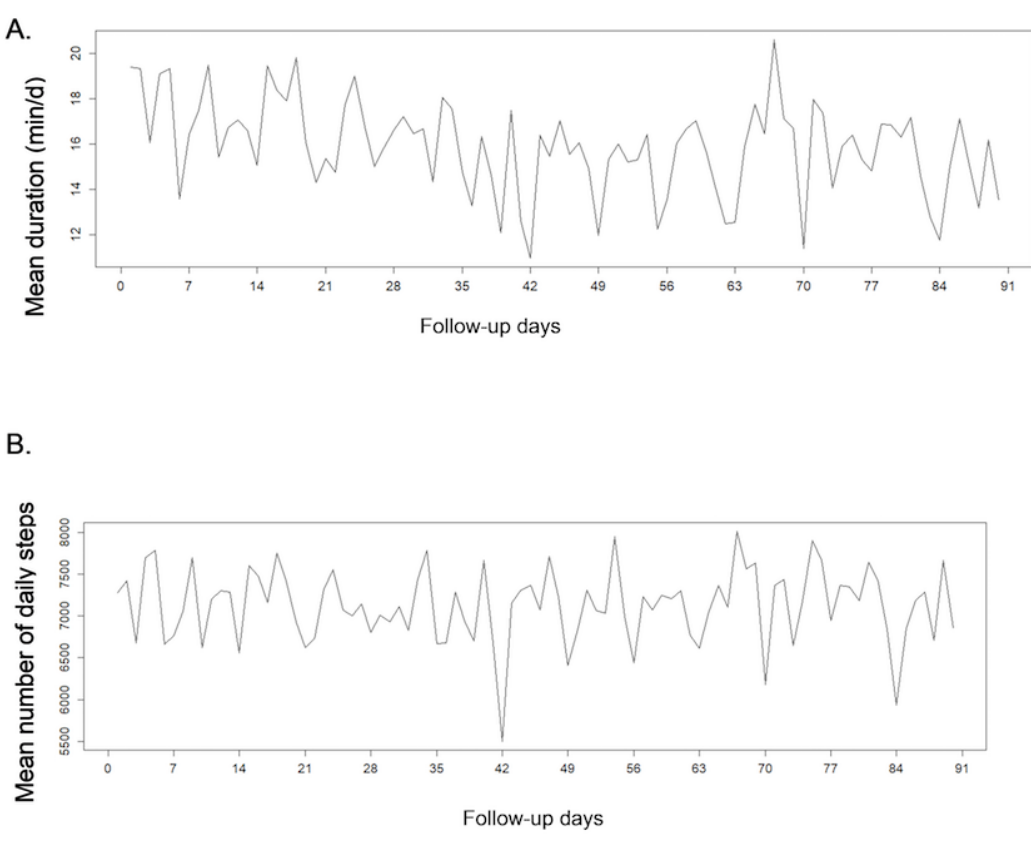
Figure 4. Weekly fluctuations of physical activity in 83 rheumatoid arthritis patients over 90 days, according to: (A) moderate to intense activity duration and (B) number of